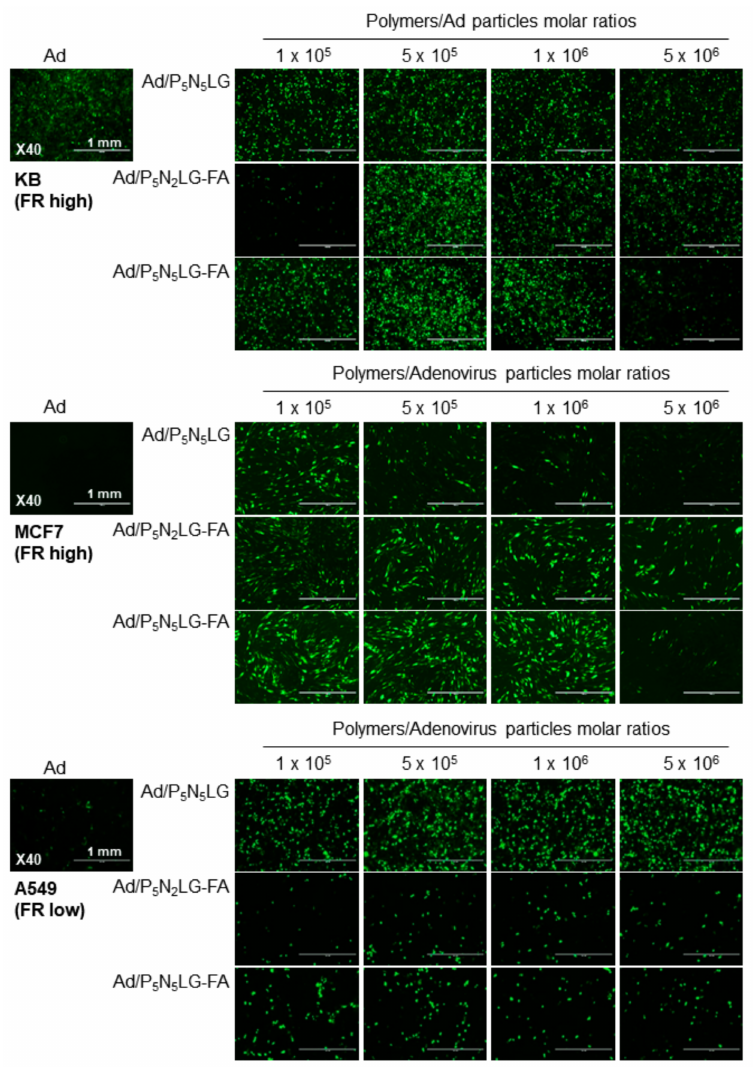
Figure 3. Transduction efficiency of Ad nanocomplexes. FR-high (KB and MCF7) and FR-low (A549) cells were treated with naked Ad, Ad/P 5 N 5 LG, Ad/P 5 N 2 LG-FA, or Ad/P 5 N 5 LG-FA at various Ad:polymer molar ratios (1 × 10 5 to 5 × 10 6 ). At 48 h after transduction, GFP expression levels were analyzed by fluorescence microscope. Original magnification rate: × 40. Scale bar is indicative of 1